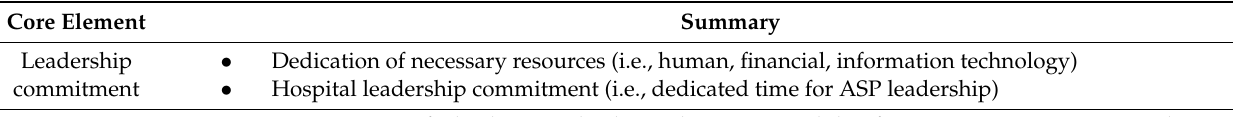
Table 1. The CDC Core Elements of Hospital Antibiotic Stewardship